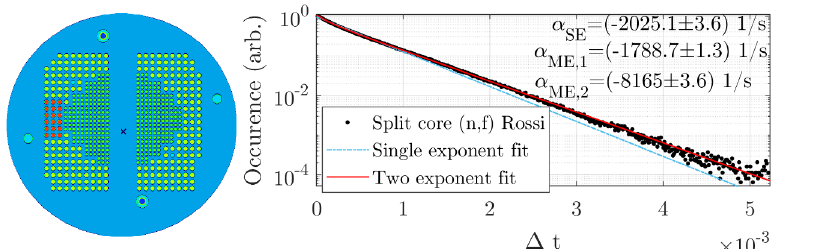
Figure 3: Left: T4 model of the CROCUS split core. Right: T4 (n,f) Rossi distribution with single (SE) and two (ME) exponent fits. The calculations used analog transport and